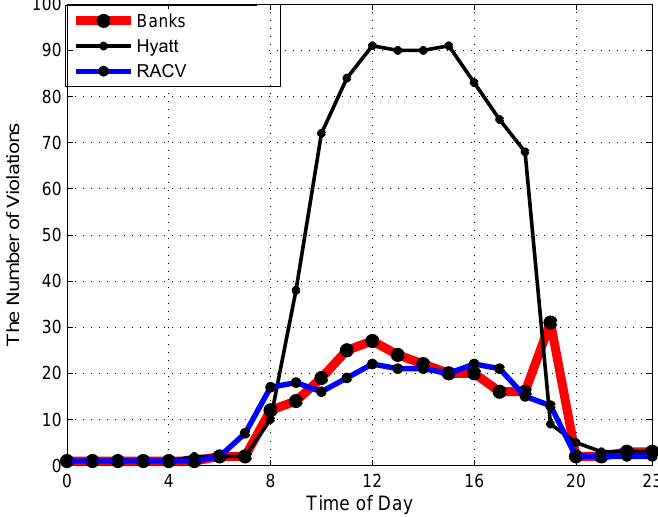
Figure 8. Temporal distribution of parking violations at different times in a